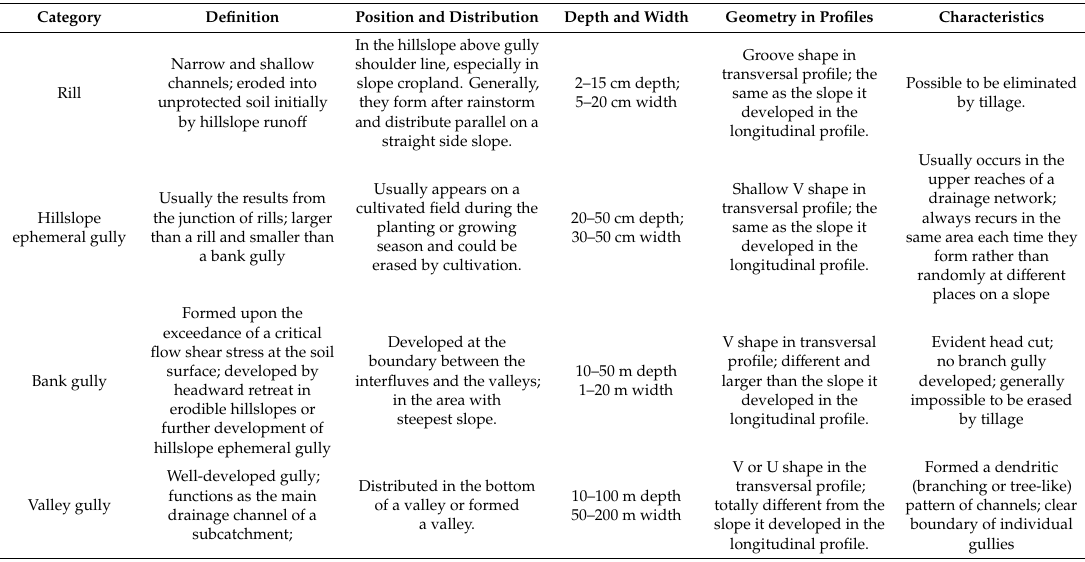
Table 1. Categories of a loess gully